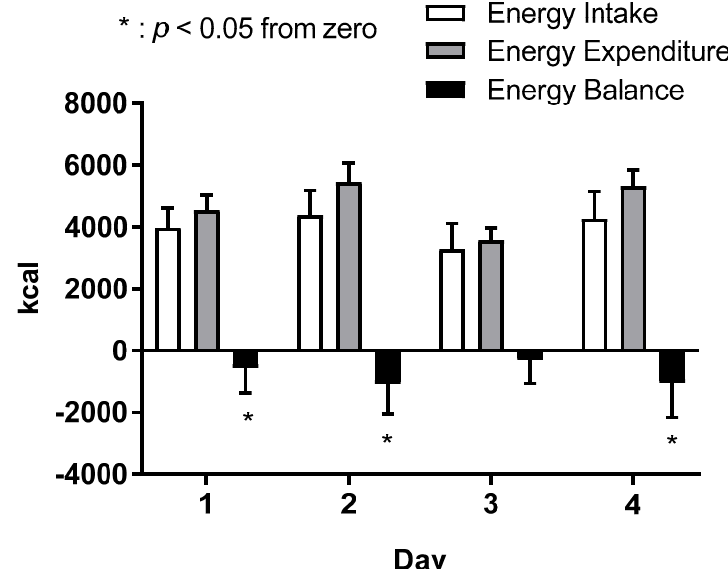
Figure 3. Energy balance (Energy intake − Energy expenditure) during the five-day experimental period. The energy balance was significantly negative on days 1, 3, and 4 ( p < 0.05). Data are shown as mean ± standard deviation ( n = 13). * p < 0.05 vs. zero.